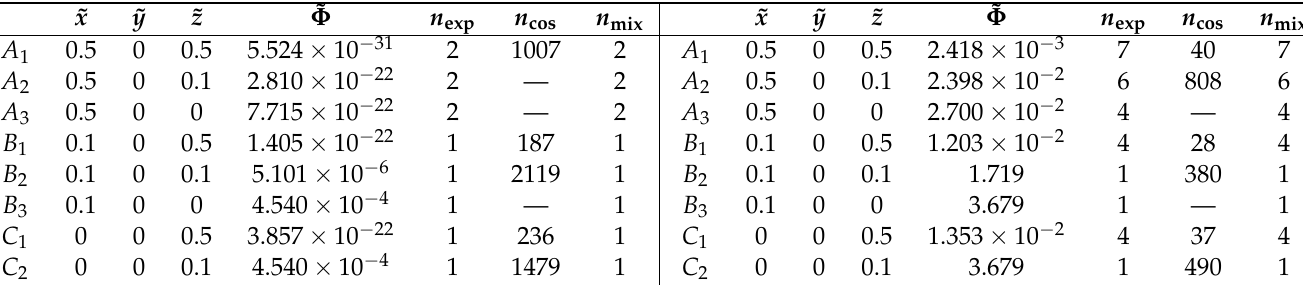
Table 1. Potentials ˜ Φ as well as the numbers n exp , n cos and n mix at a selection of points for ˜ λ eff = 0.01 and ˜ λ eff = 0.1 in the left and right tables,